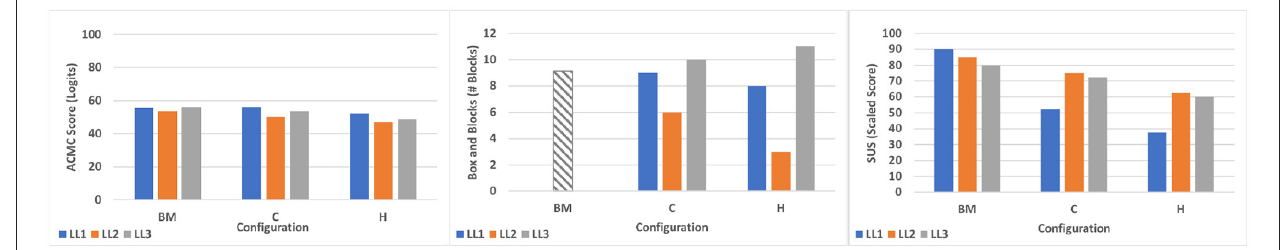
FIGURE 7 | Results from subjects with limb loss testing the two hybrid configurations in comparison with the benchmark. Box and Blocks data of the benchmark are extracted from Godfrey et al. (2018).